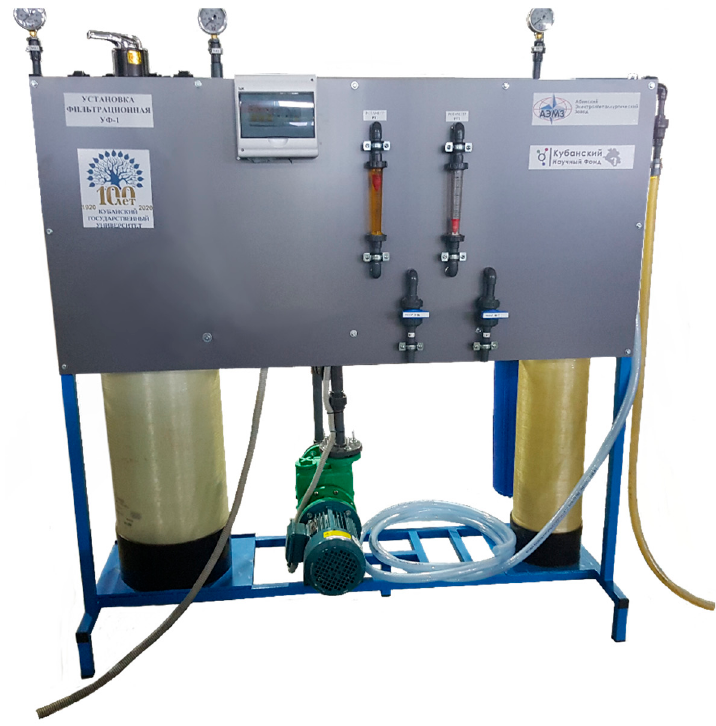
Membranes 2022 , 12 , 1196